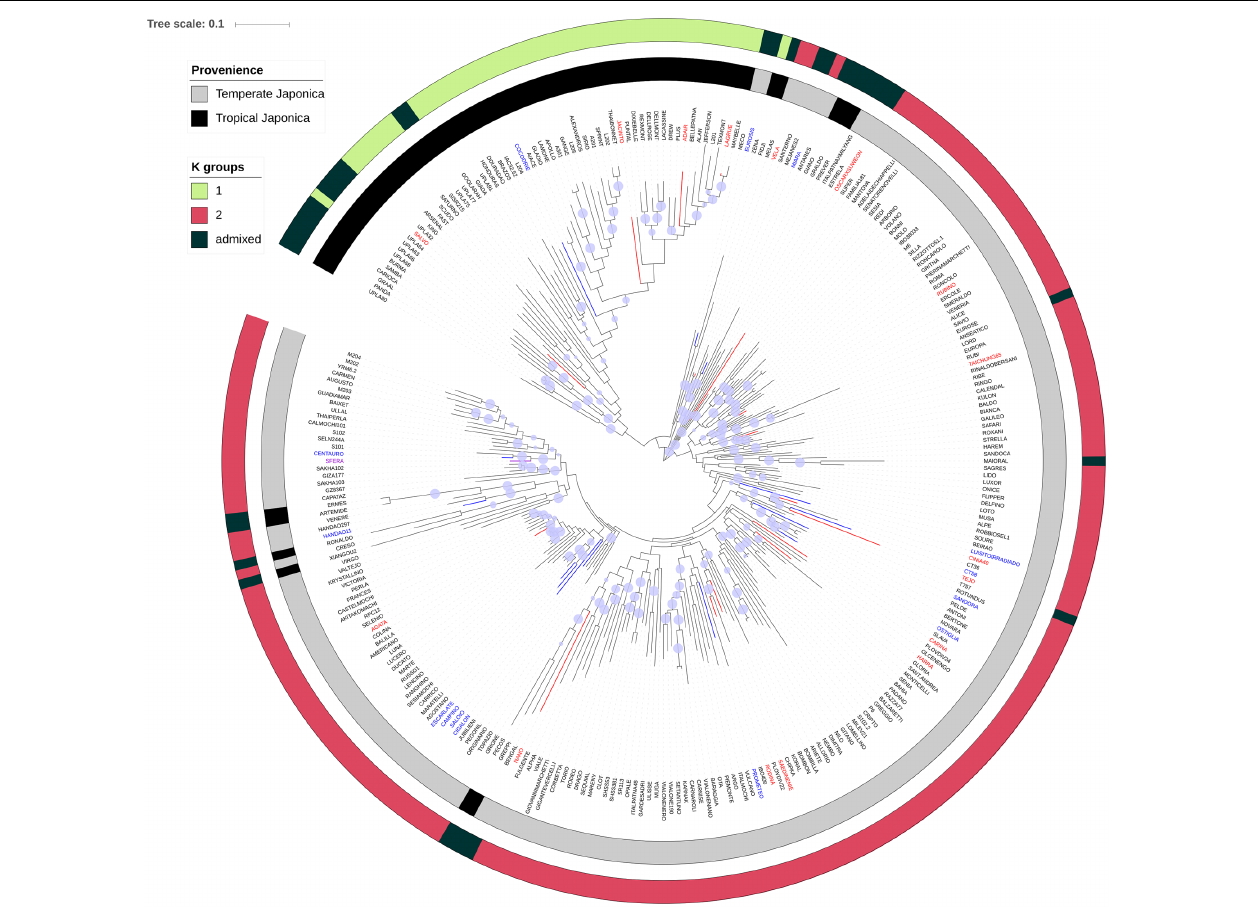
FIGURE 5 | Neighbor-joining tree of the rice panel used in the study. The blue circles on each branch show the results of the bootstrap analysis, when higher than 0.7. The inner gray-and-black coded cycle represents the clustering of the different varieties of the panel according to O. sativa classification; the outer cycle (three-color scaled) reports the cluster organization resulting from the STRUCTURE analysis. The rice accessions showing LW/PF values for the PW, HGW, and both traits above the 95 percentile were, respectively, blue, red, and violet highlighted in the neighbor-joining